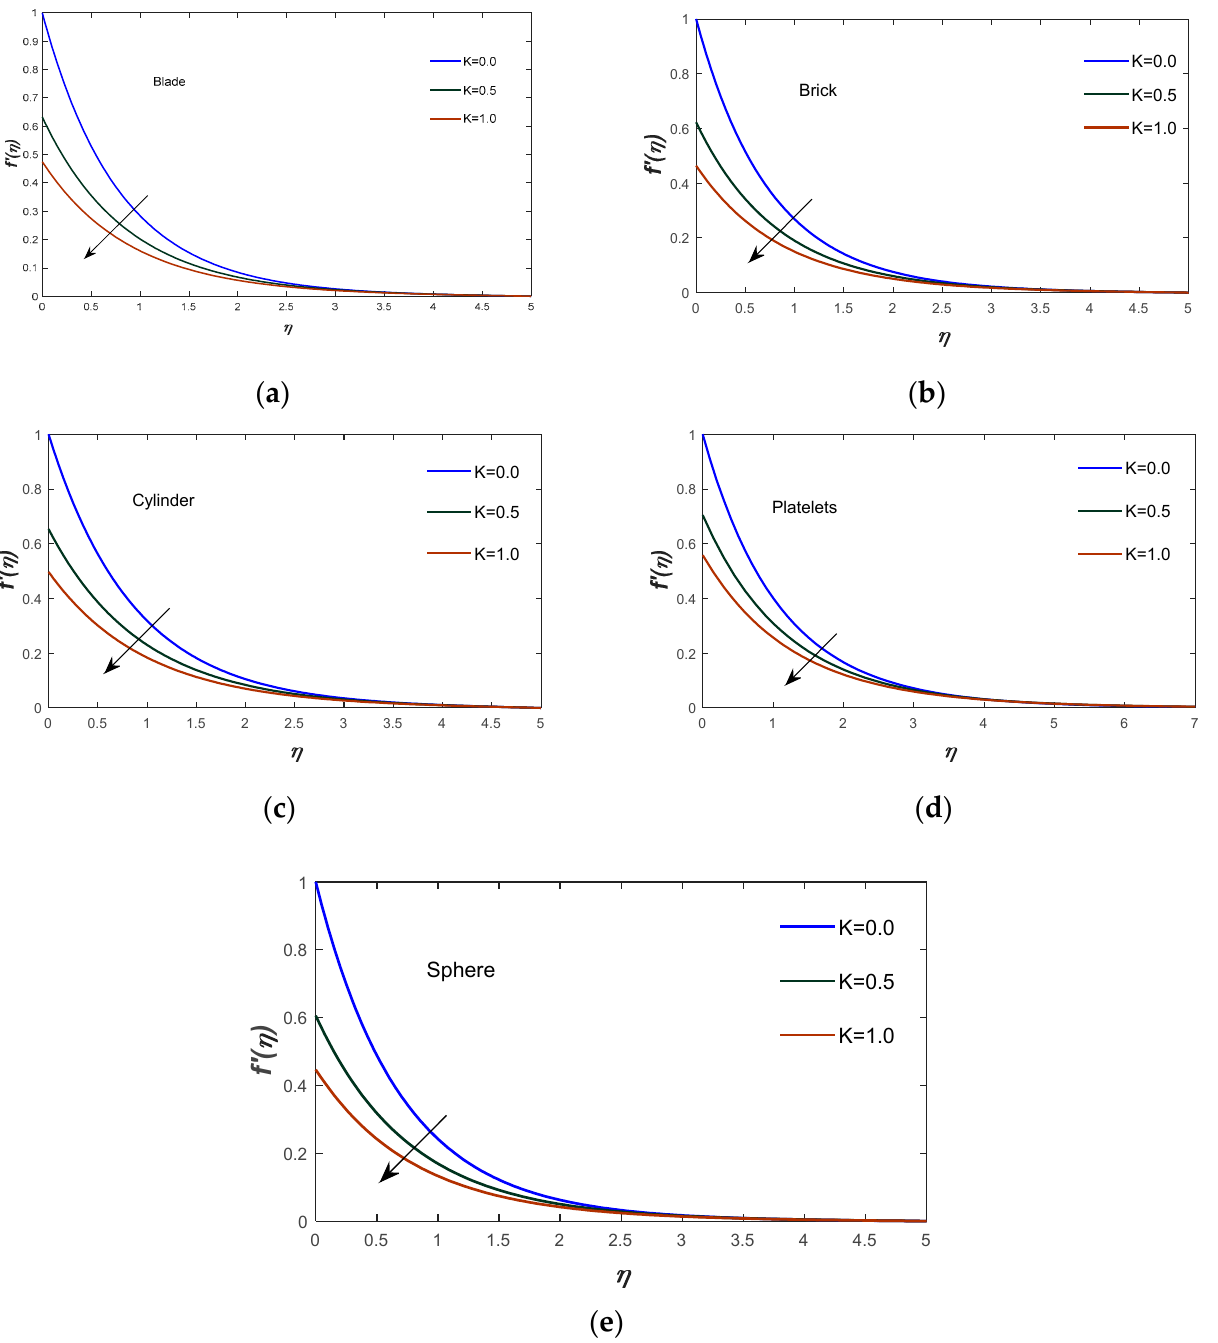
Figure 4. ( a – e ). Impact of on 𝑓′(𝜂) by using various shapes factors of nanoparticles for fixed 𝑀 = 1.0, 𝑃𝑟 = 6.0, 𝑆 = 0.5, 𝐸𝑐 = 1.0, 𝜑 = 0.02 .